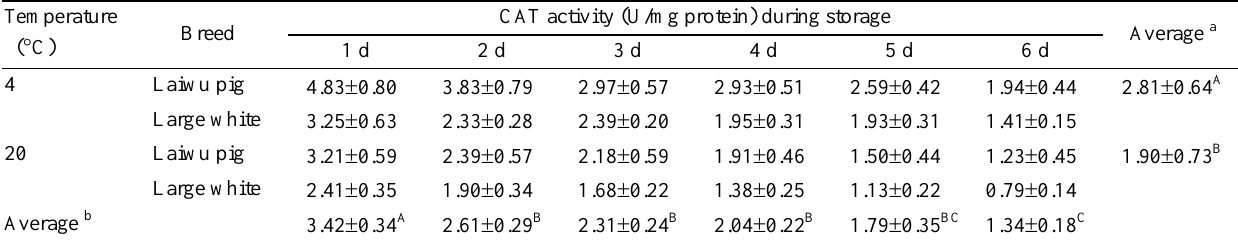
Values in each cell are mean  SEM ( n = 6). a Values bearing different superscripts differ significantly in two different storage temperatures (p<0.01). b Values bearing different superscripts differ significantly in different storage times (p<0.01).